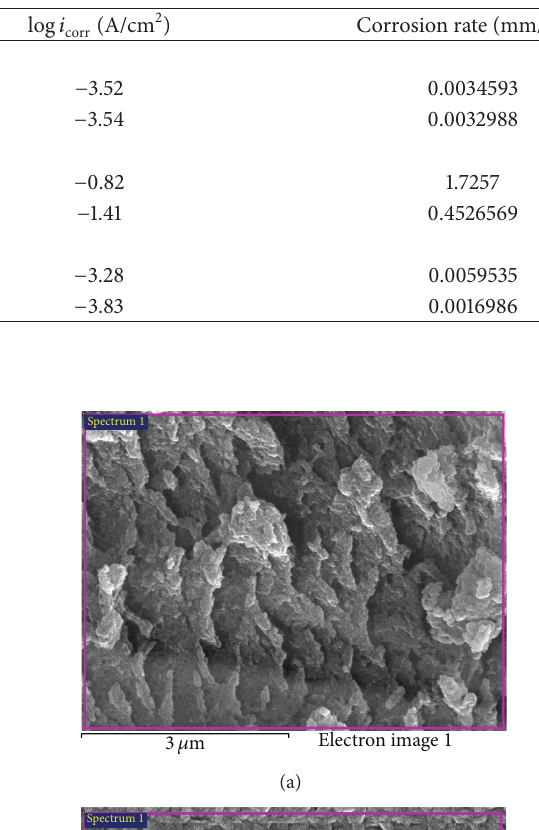
Table 2: Corrosion parameters derived from the polarization curves of bare and coated alloy plates in NaCl, H